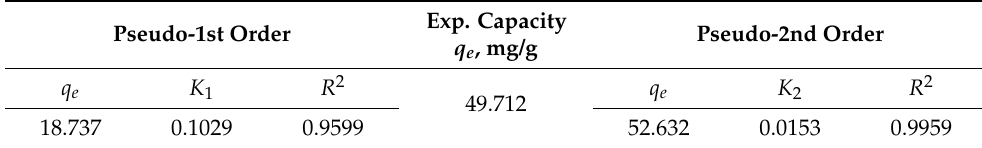
Table 1. The parameters of Cd 2+ extraction kinetic by Adogen 464. Pseudo-1st Order